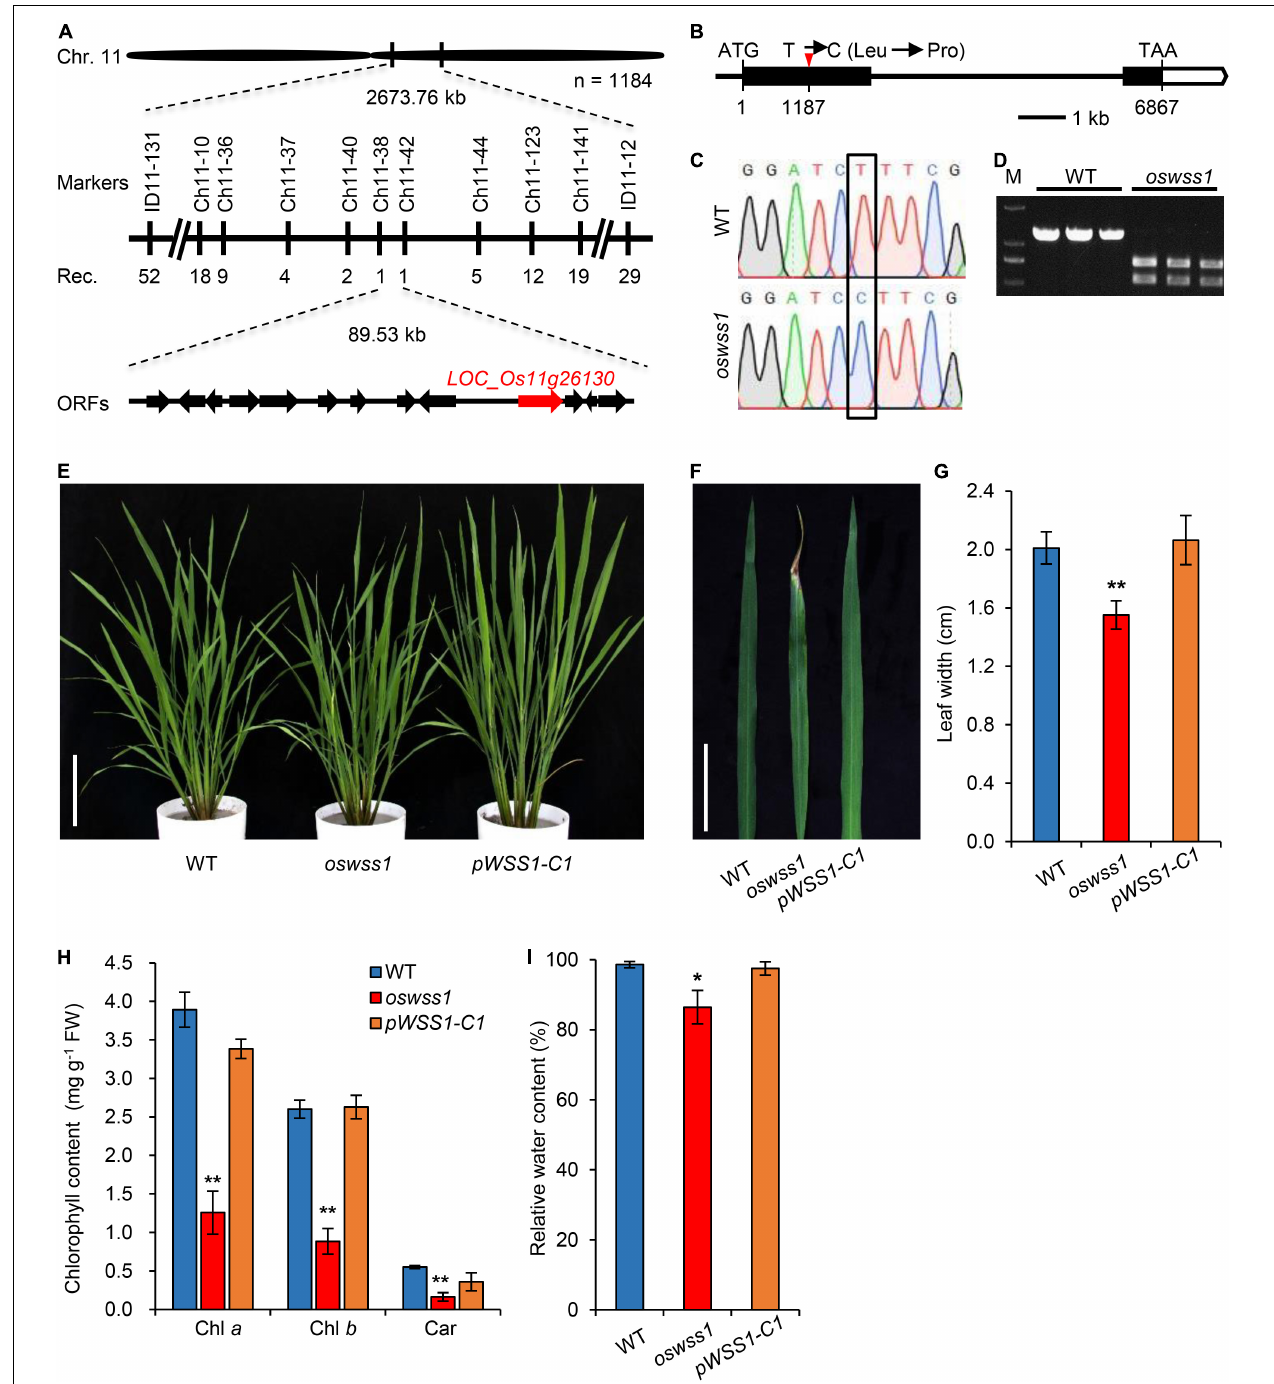
FIGURE 4 | Map-based cloning of OsWSS1 and complementation test. (A) Fine mapping of OsWSS1 . The OsWSS1 locus was mapped to an 89.53 kb genomic region on chromosome 11 between markers Ch11-38 and Ch11-42. The molecular markers and recombinant numbers are displayed. (B) The structure and mutation site in OsWSS1 . The white boxes, black boxes, and black lines represent untranslated regions, exons, and introns, respectively. (C) DNA sequencing to confirm the point mutation of the OsWSS1 in the oswss1 mutant. The black box indicates the mutation position. (D) Confirmation of the mutation by cleaved amplified polymorphic sequence. PCR products from oswss1 were digested by Bam HI while PCR products from wild type (WT) were not digested by BamH 1. (E) The plant morphology among WT, oswss1, and complementation transgenic line at the initial tillering stage (60 DAS). Scale bar = 15 cm. (F) Leaf morphology among WT, oswss1 and complementation transgenic line at the tillering stage. Scale bar = 5 cm. (G) Comparison of leaf width of WT, oswss1, and complementation plants. (H) Comparison of chlorophyll content of WT, oswss1, and complementation plants. (I) Relative water content among WT, oswss1, and complementation leaves. Values are mean ± SD ( n = 6). * P < 0.05, ** P < 0.01 (Student’s t